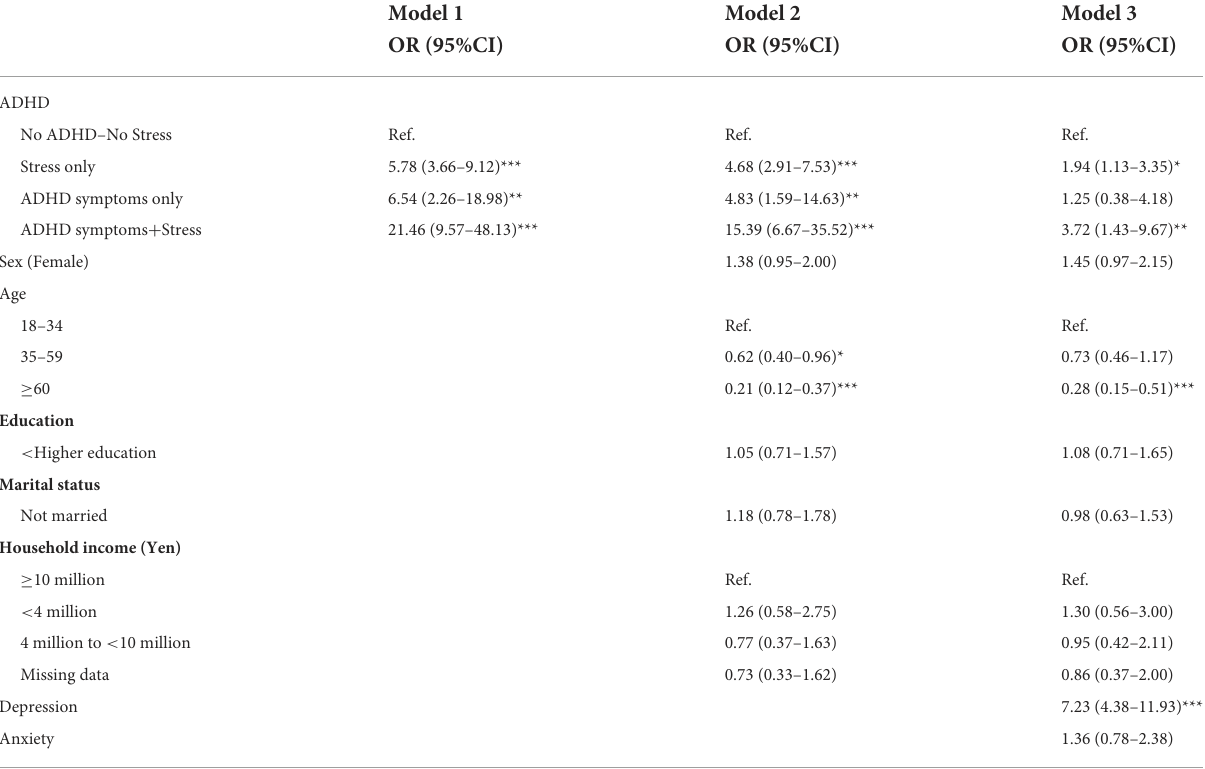
TABLE 4 Association between ADHD symptoms, perceived stress and suicidal ideation in Japan during the COVID-19 pandemic ( N =